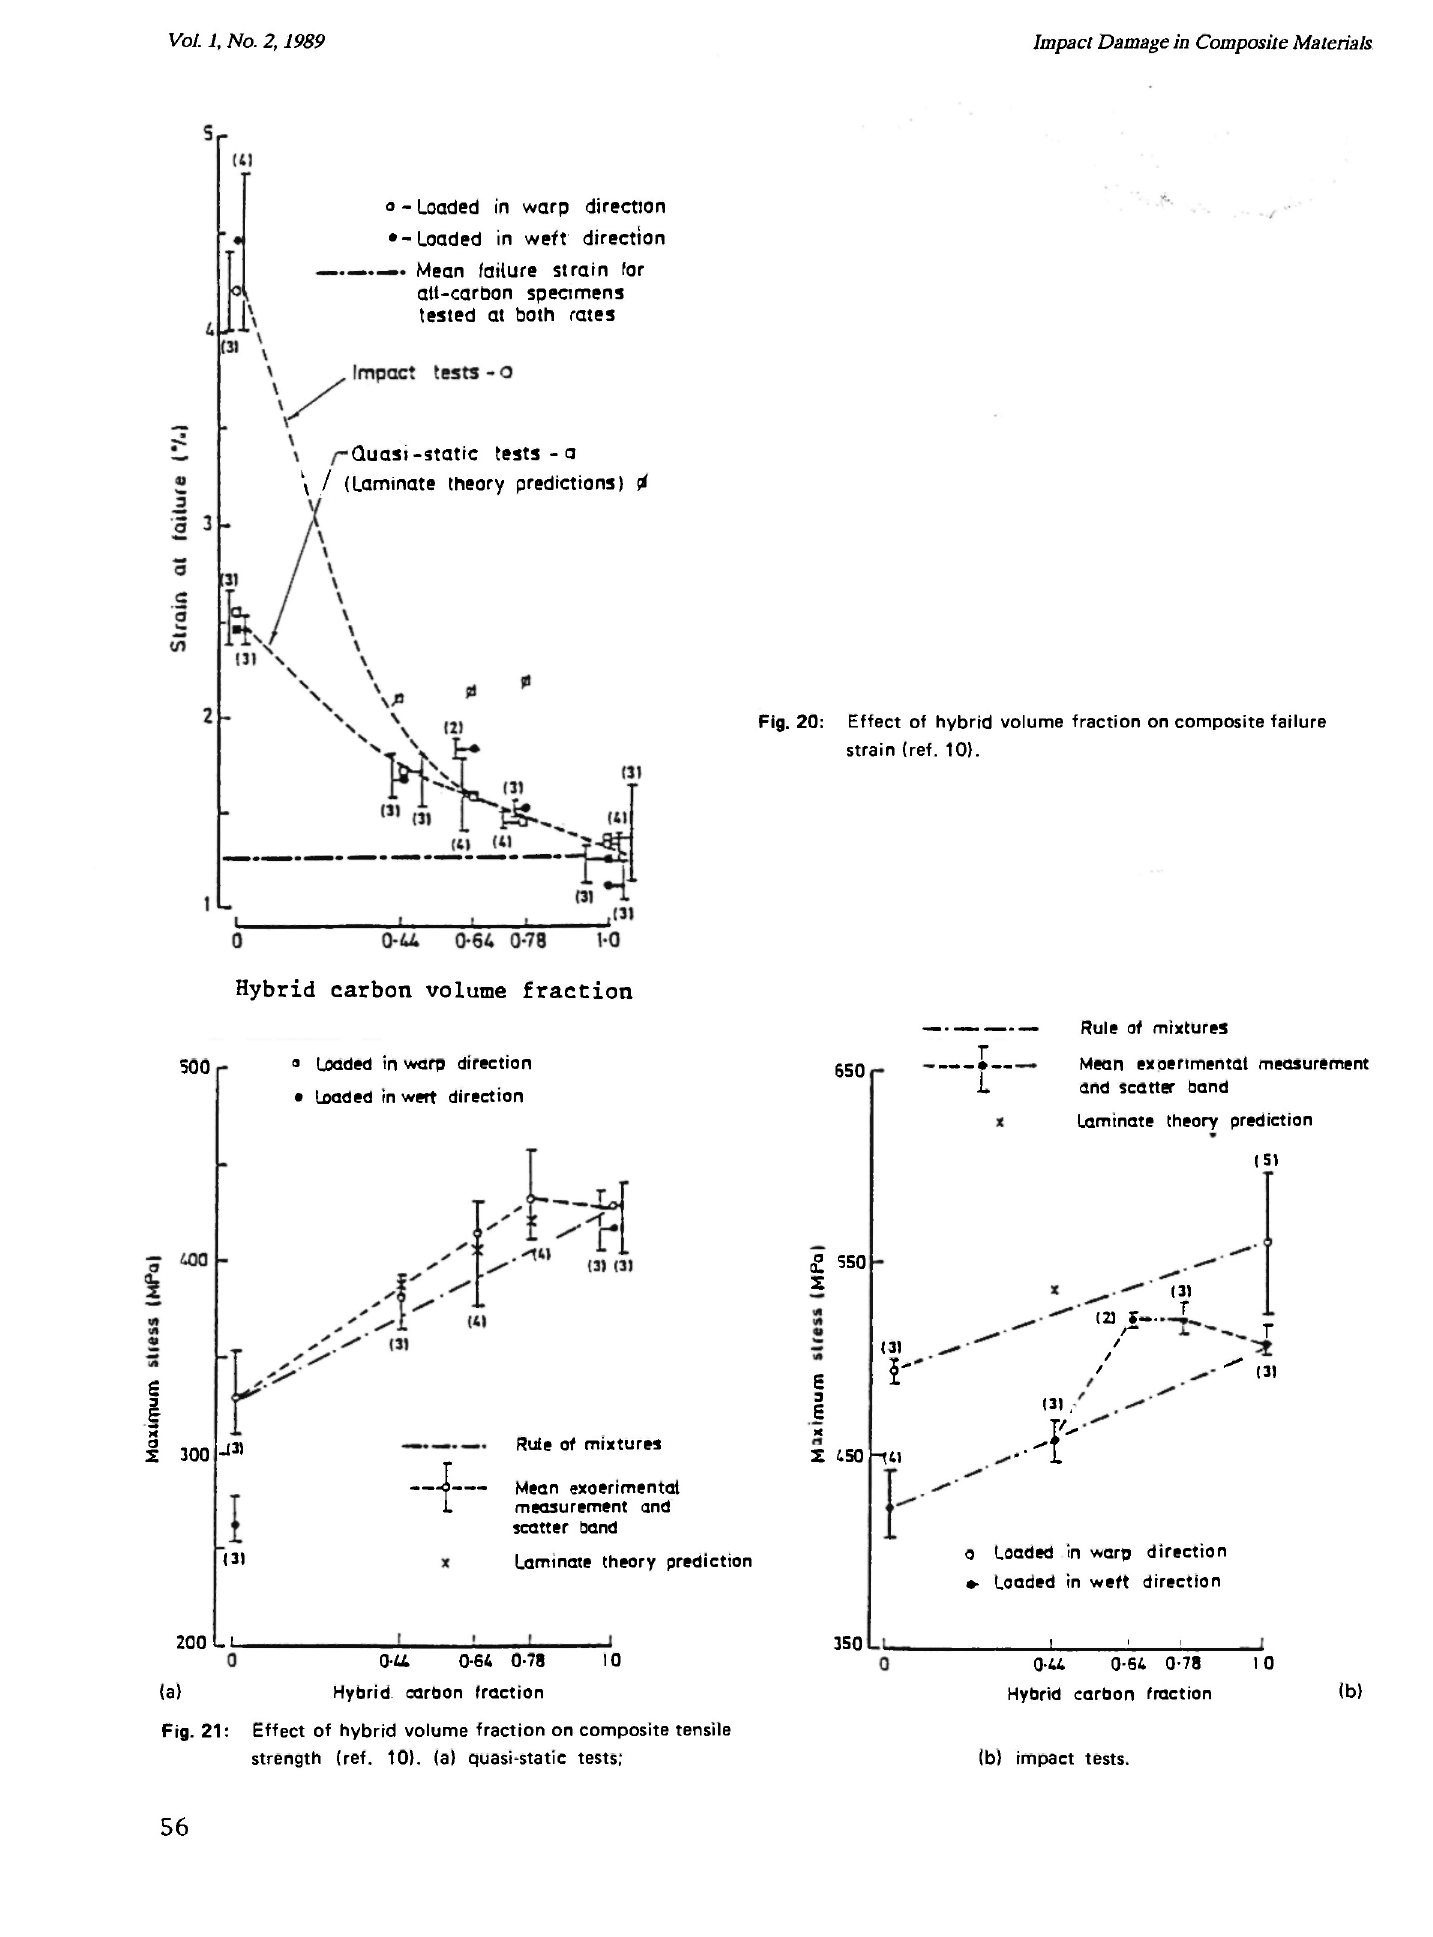
Fig. 20: Effect of hybrid volume fraction on composite failure strain (ref. 10).